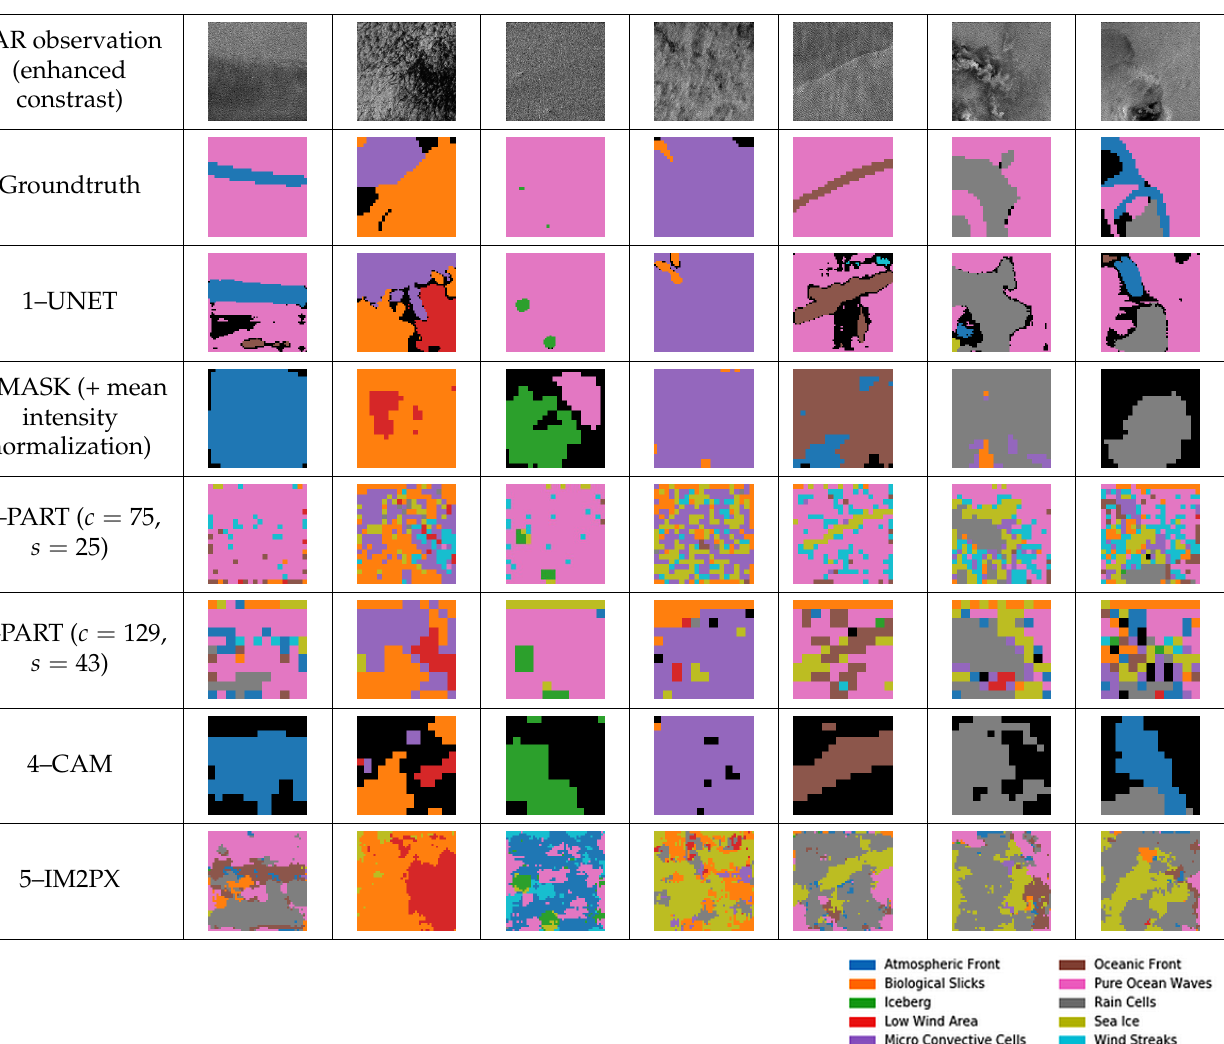
Figure 4. Examples of output on elements of the test set for each segmentation method. Pixels in black are below a decision threshold of 0.5 and left